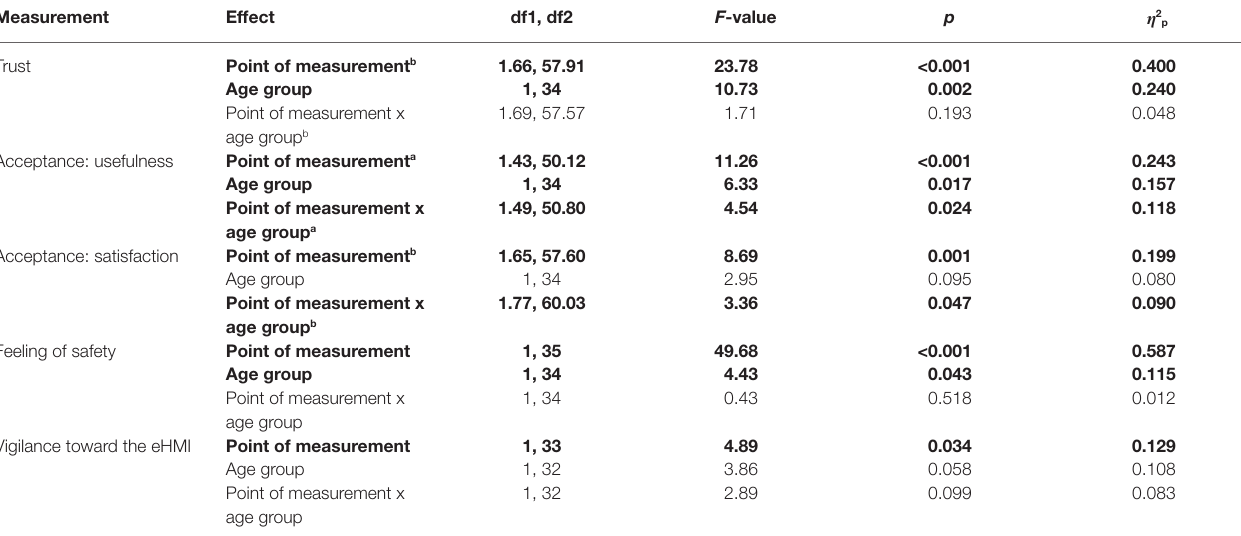
TABLE 3 | Mixed ANOVA results displaying the main and interaction effects of the investigated factors points of measurement (within-subject factor) and participants’ age groups (between-subjects factor).